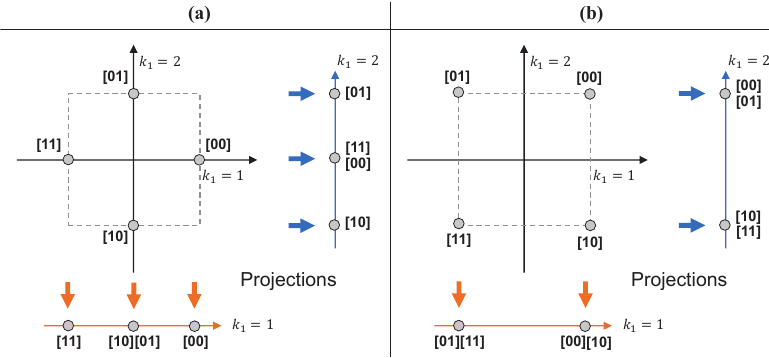
Figure 4. Comparision of symbol mapping for M = 4 and K 1 = 2. ( a ) ˜ M = 3 projection points; ( b ) ˜ M = 2 projection